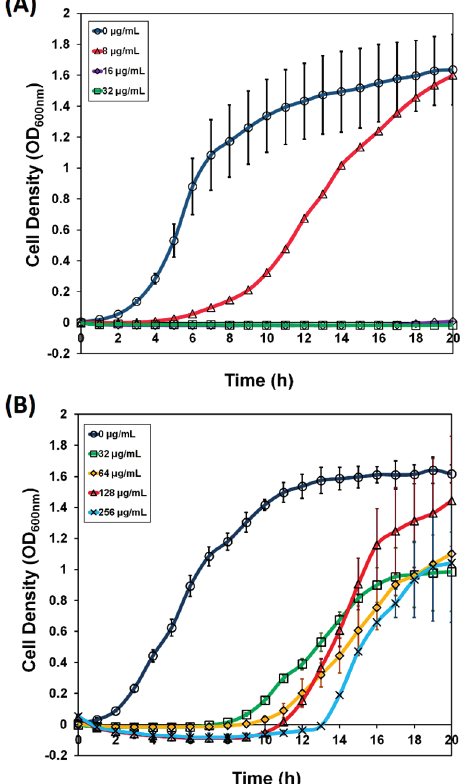
Figure 1. Growth of the E. coli W3110 imp4213 (pCA24N) and E. coli W3110 imp4213 ASKA pooled-plasmid library culture in Luria broth media supplemented with chloramphenicol (30 µg/mL) and with various concentrations of xanthorrhizol. Growth was monitored for 20 h in an automatic incubator (TVS1 Bio-Photorecorder, Advantec, Shiga, Japan). ( A ) E. coli W3110 imp4213 (pCA24N) was grown in the present of xanthorrhizol 0, 8, 16 and 32 µg/mL. The growth was inhibited at 16 µg/mL; ( B ) E. coli W3110 imp4213 ASKA pooled-plasmid library was grown in LB media with various concentrations of xanthorrhizol after three rounds of enrichment. The xanthorrhizol concentrations used were 0, 32, 64, 128, and 256 µg/mL. The library clones that grew after the delay exhibited resistance towards